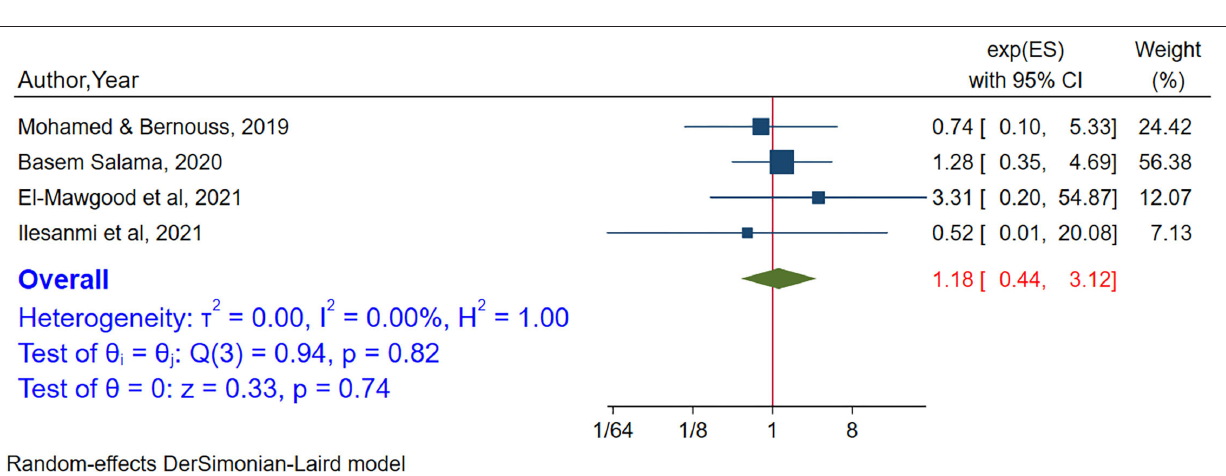
FIGURE 9 | The pooled association between mothers’ education and internet